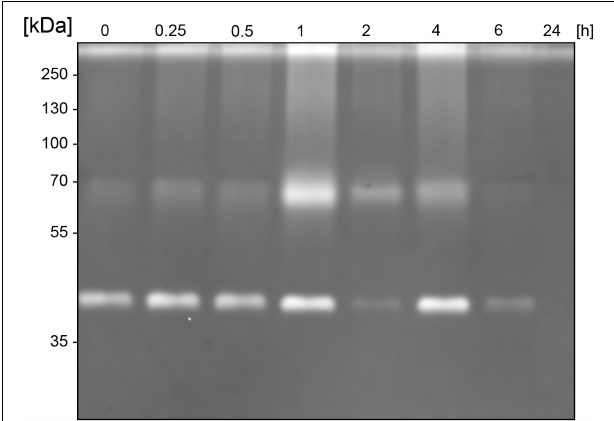
FIGURE 3 | Sustained activity of BspE autoproteolytic fragments. Casein zymography showing the sustained activity of two BspE fragments with molecular weights of ∼ 70 and ∼ 40 kDa following autoproteolysis. The zymography shows a diminishing activity up to 6